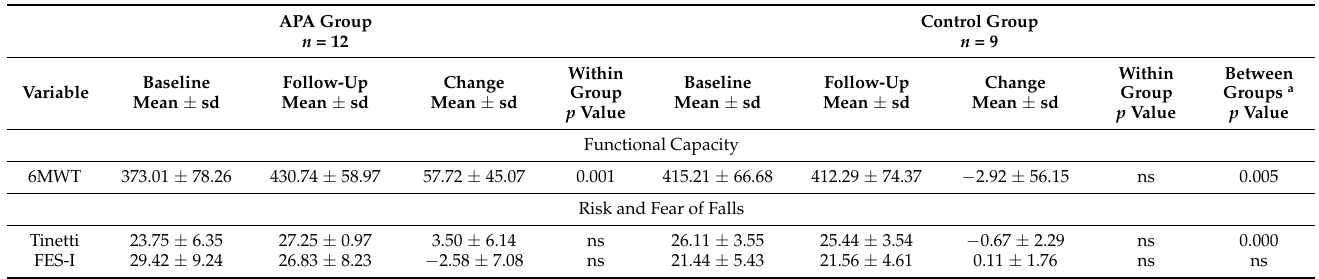
Table 3. Functional Capacity, Risk and Fear of Falls Assessments measured in the two study -groups at baseline, follow-up, and change at 6 months. Outcome measures at baseline, follow-up, and change at 6